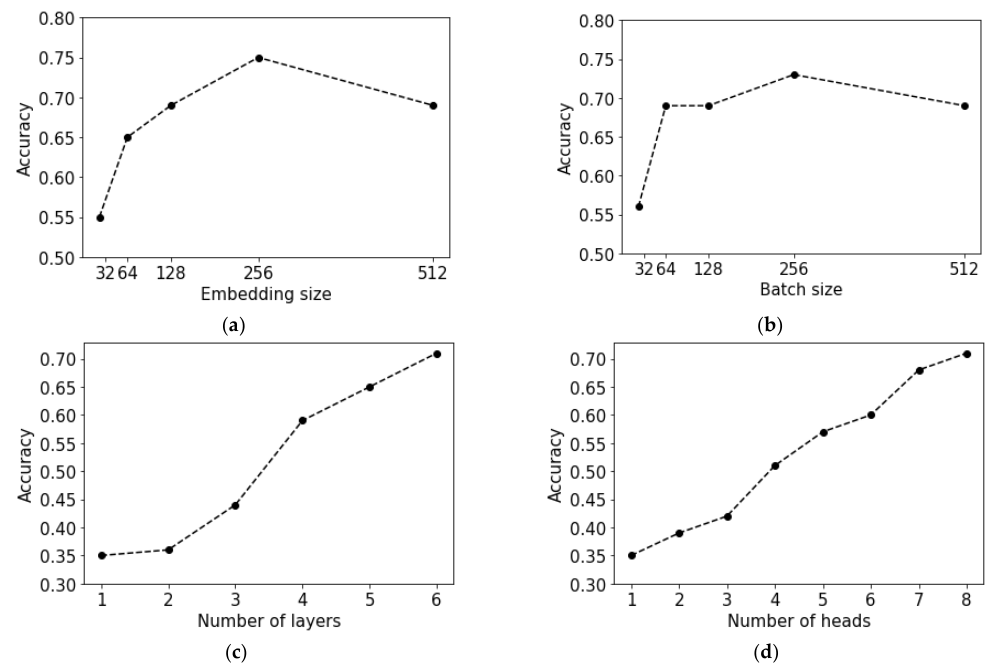
Figure 5. Matching accuracy of the transformer network with regards to the embedding size ( a ), the batch size ( b ), the number of layers both in the encoder and decoder ( c ), and the number of attention heads ( d ).